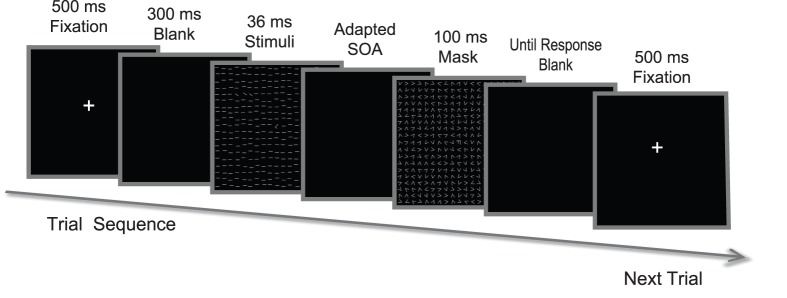
Trial sequences of texture discrimination task.